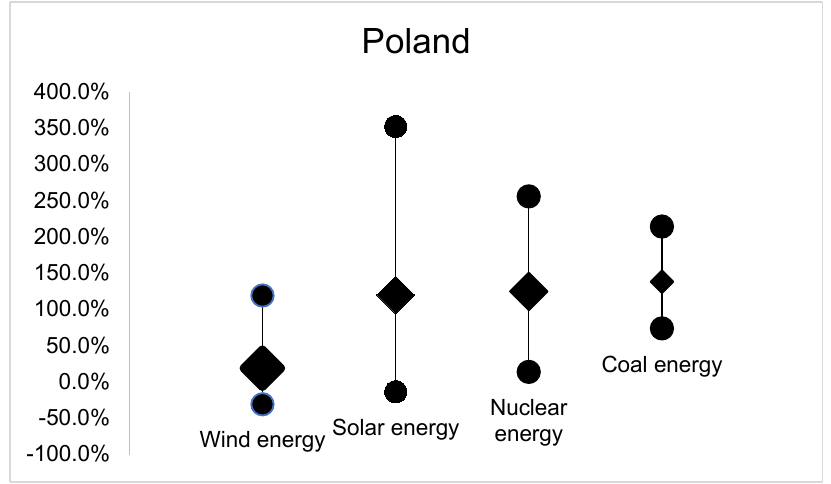
Figure 13. Willingness to pay for various types of electric energy in Poland . Source: own study.